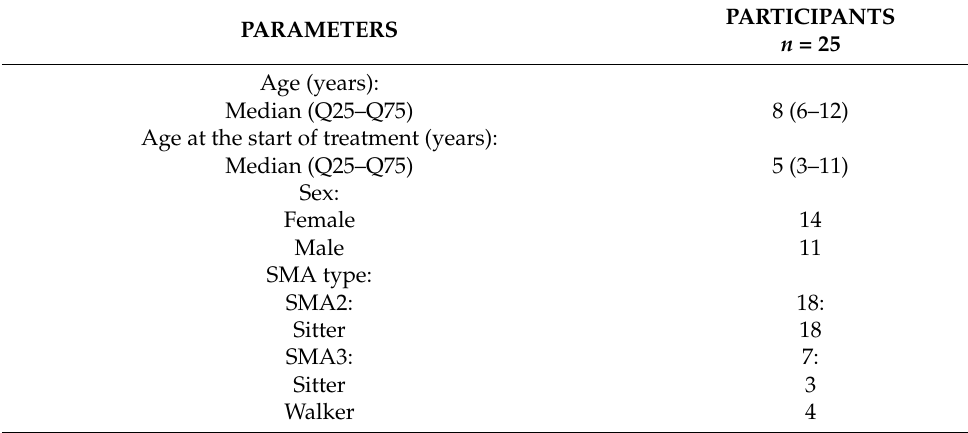
Table 1. Study group